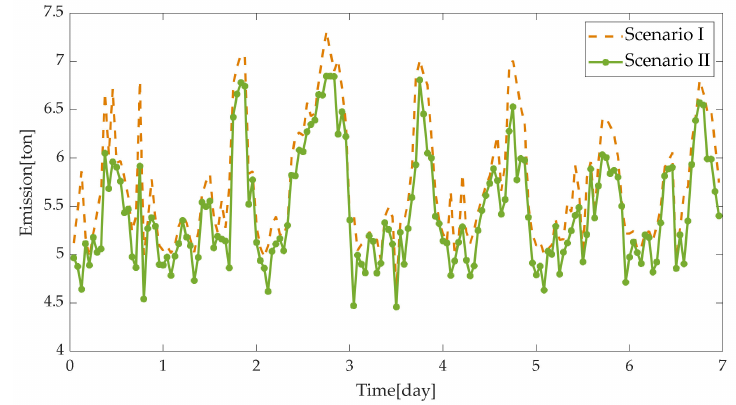
Figure 8. Comparison of NO x emission.